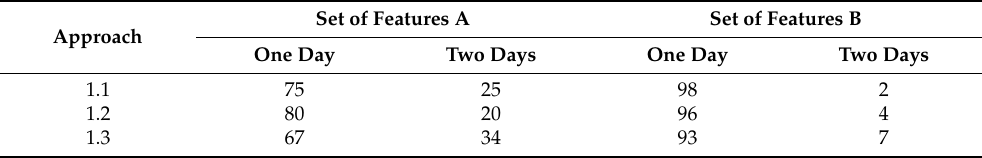
Table 8. Percentages of clusters with appointments that have the same target day and two target days in the clustering results of the sets of features A and B that are used to obtain the results in Table